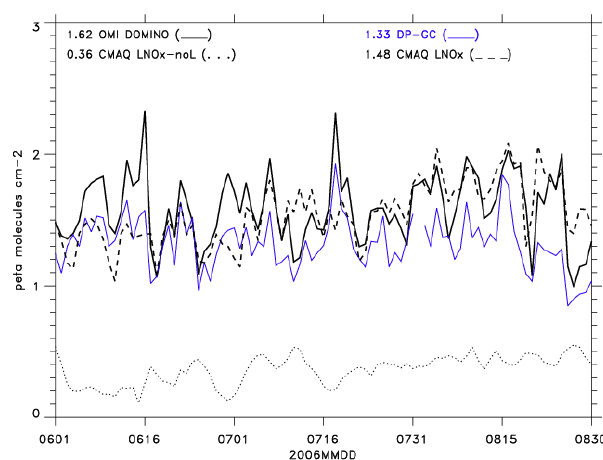
Figure 4. Time series comparing area-averaged (110°-70°W, 25°-45°N) tropospheric NO 2 columns for June-August 2006. Solid blue (black) line shows the mean DP-GC Fig. 4. Time series comparing area-averaged (110 ◦ –70 ◦ W, 25 ◦ – (version 2.0 DOMINO) column. The dashed line shows averaging-kernel processed 45 ◦ N) tropospheric NO 2 columns for June–August 2006. Solid model output from simulation LNO x . The dotted line shows the contribution of lightning-NO production to the total model column (simulation LNO x – simulation noL). blue (black) line shows the mean DP-GC (version 2.0 DOMINO) column. The dashed line shows averaging-kernel processed model output from simulation LNO x . The dotted line shows the contribu- tion of lightning-NO production to the total model column (simula- tion LNO x – simulation